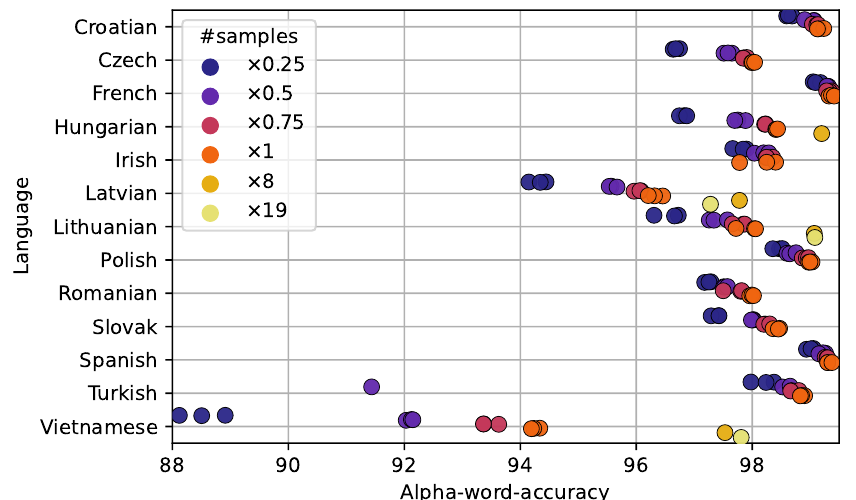
Figure 2. Alpha-word accuracy improvement during diacritics restoration training. Training steps of × 1 corresponds to 2048 × 256 sentences for a given language. There is a visible outlier for the Turkish language at × 0.5 training steps, but that model regained the accuracy later in